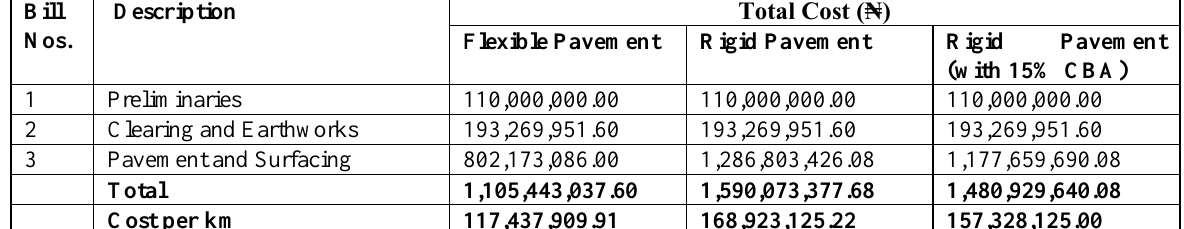
Table 2: Summary of Initial Cost for Pavements for road length of 9.413 KM.